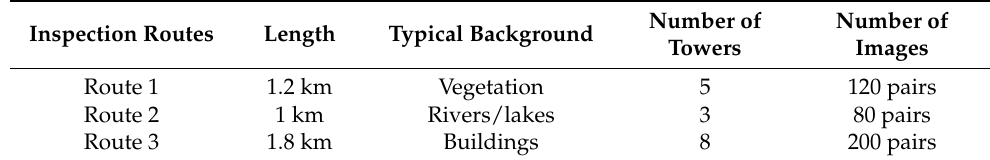
Table 1. Information on inspection routes.